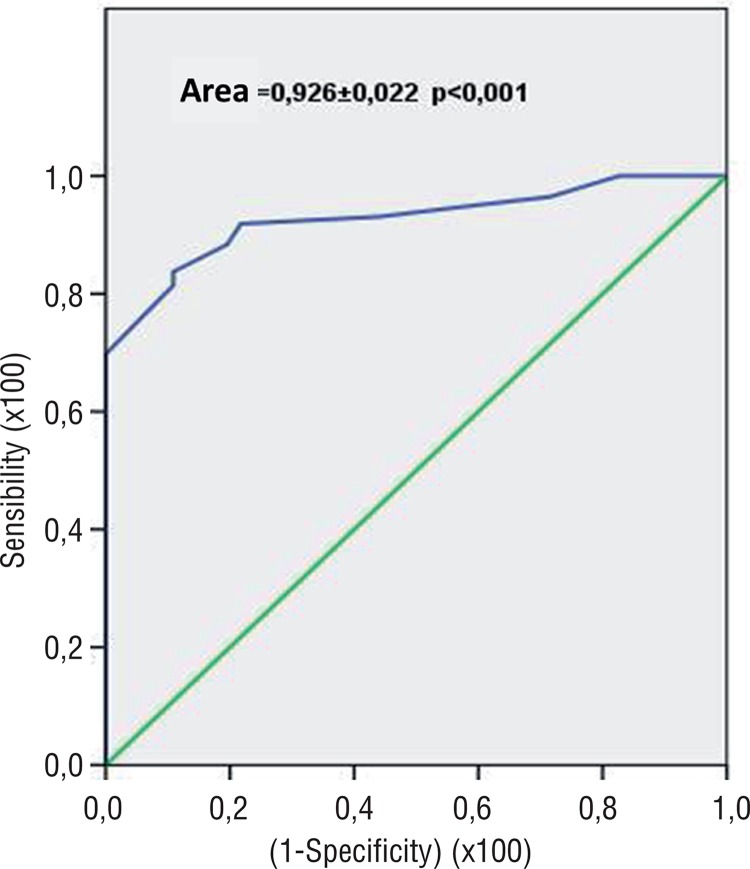
ROC curve of IIEF-5 and CAD